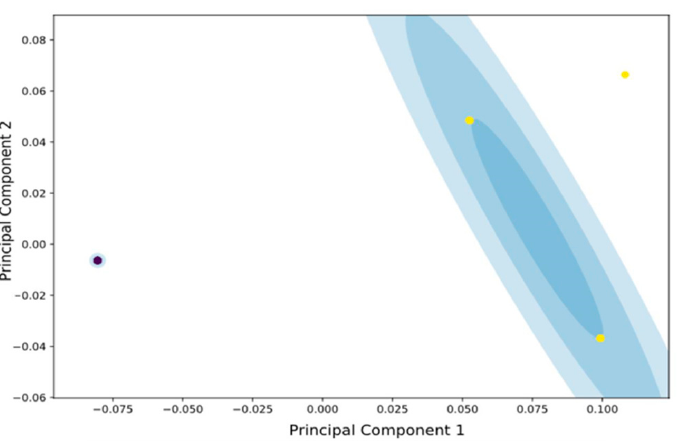
Figure 4. Gaussian mixture modeling of the samples of 11 B. bruxellensis strains in the 6 independent cultures considered. Yellow points represent the samples from planktonic cells, while blue represent attached cells. The blue shaded areas represent the Gaussian distributions corresponding to each cluster. For the planktonic cells, the distribution presents larger variance in comparison to the biofilm cell state.